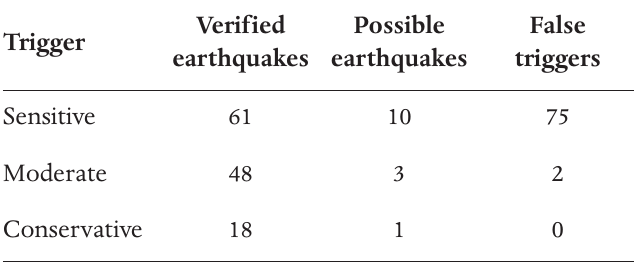
Table 1. Number of verified, possible, and false triggers for different trigger sensitivities. Detection time is very fast, with about 75% coming in before two